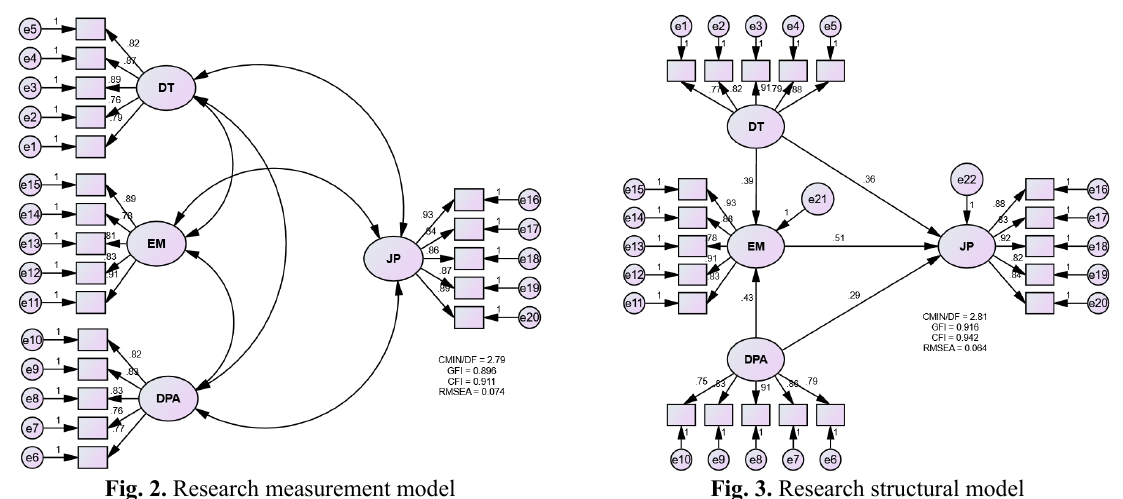
Fig. 2. Research measurement model Fig. 3. Research structural